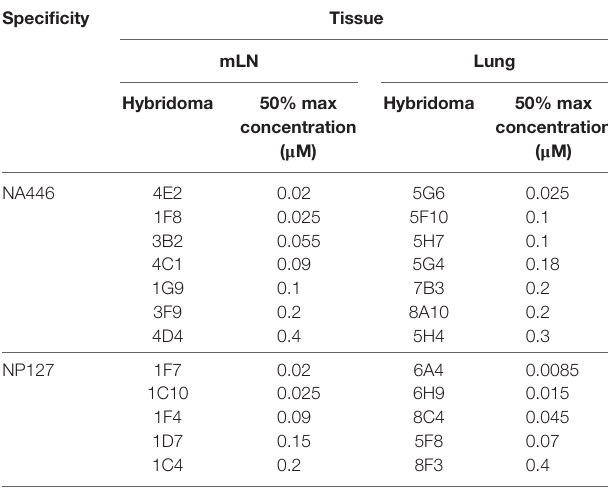
Table 2 | Relative affinities of T cell hybridoma